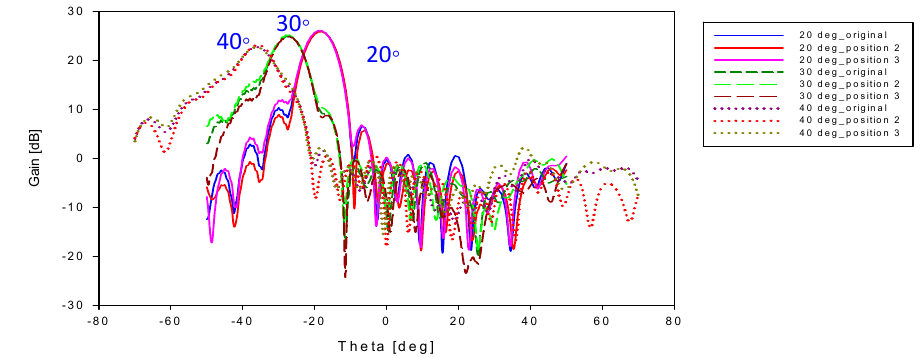
Figure 26. Antenna gain for all feed position for energy conservation lens.